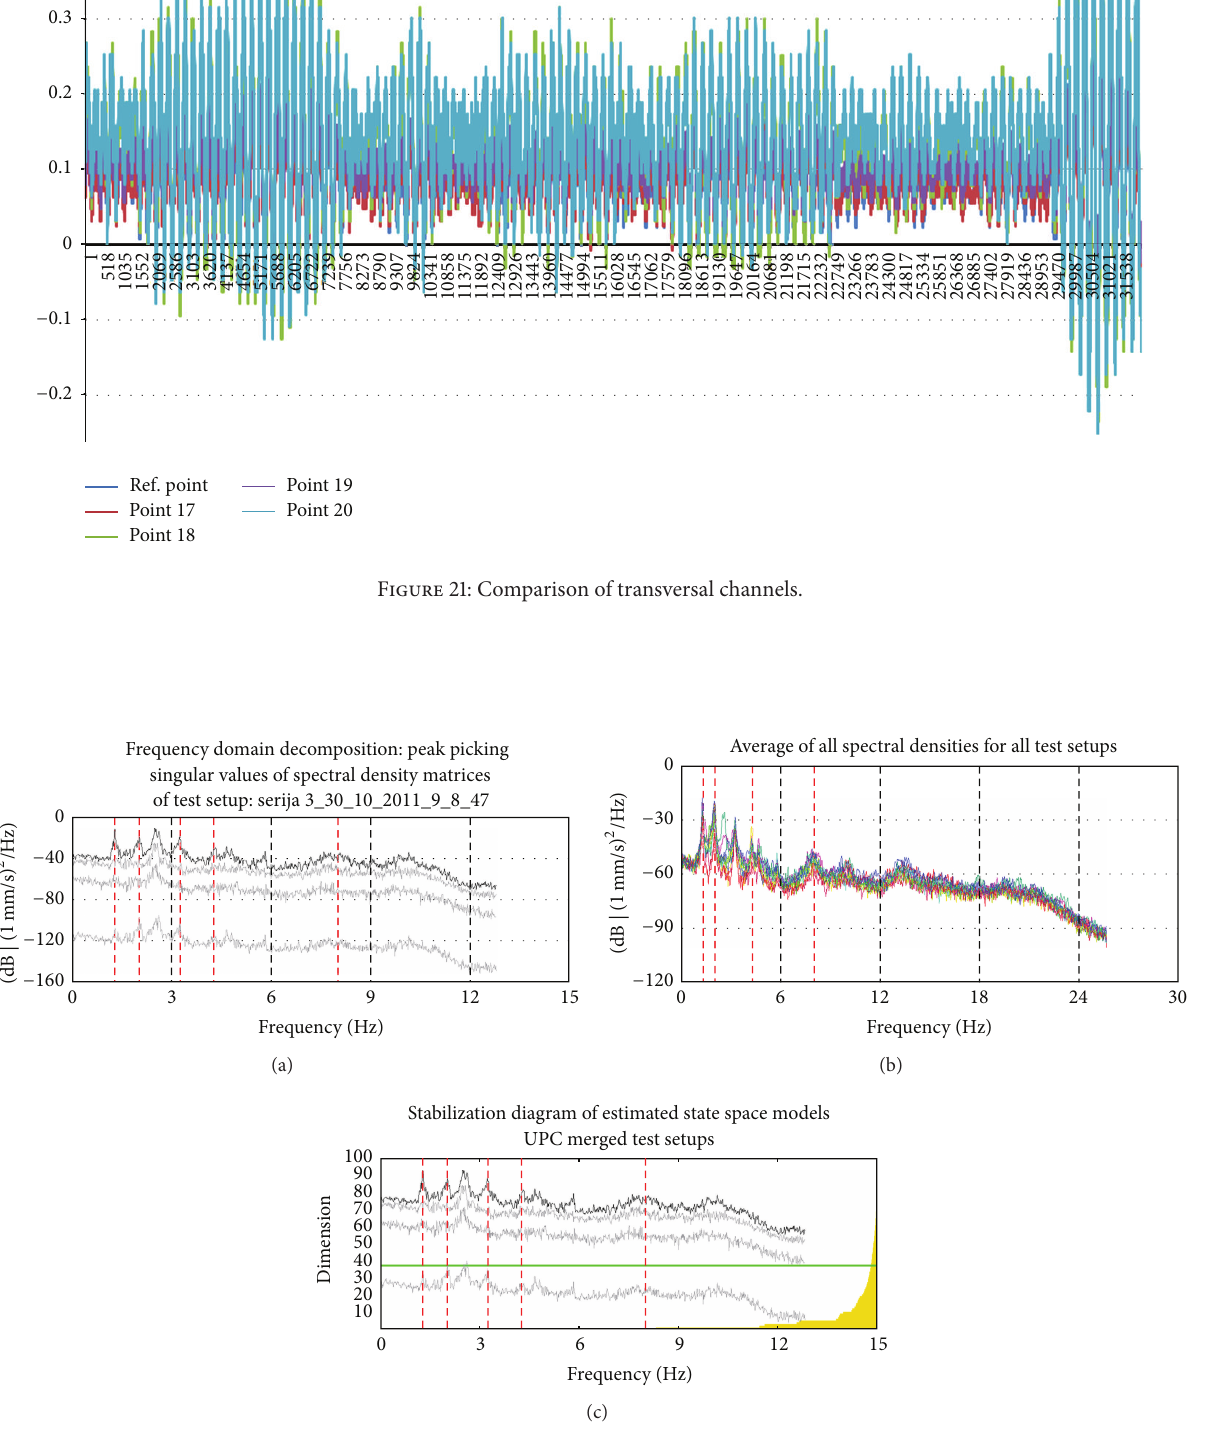
Figure 22: Dynamic characteristics attained from the test using PP and SSI method: (a) singular values of spectral density matrices, (b) average of auto spectral densities, and (c) stabilization diagram of estimated state space